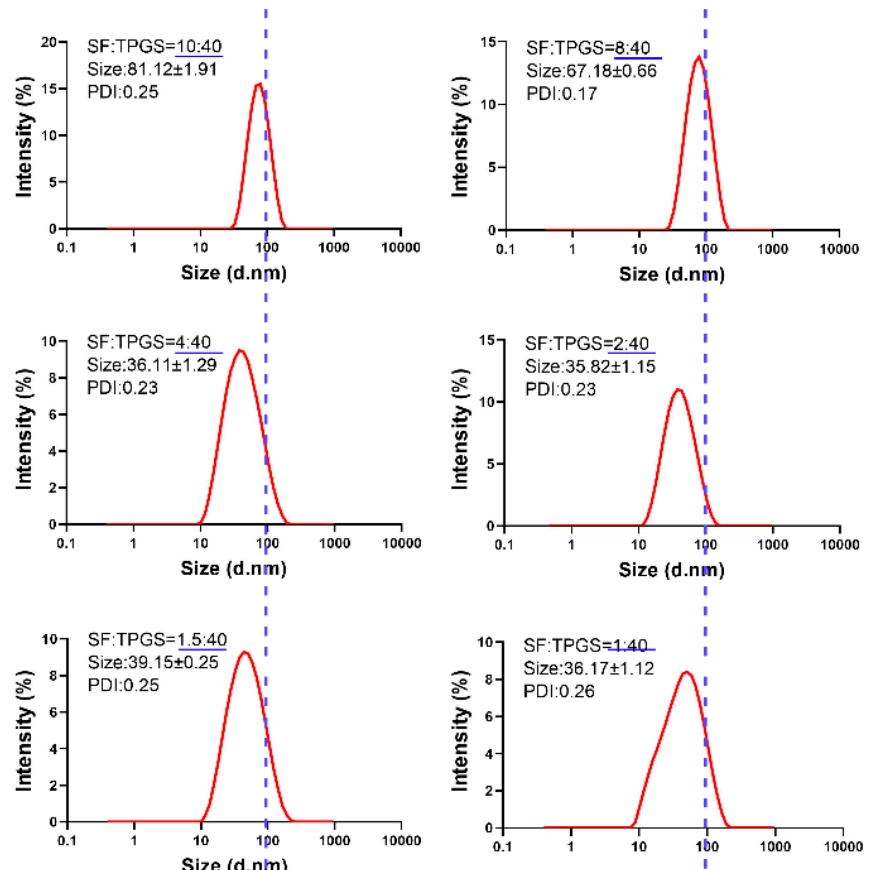
Figure A2. Size distribution of SF micelles with different mass ratios of SF:TPGS measured by DLS.